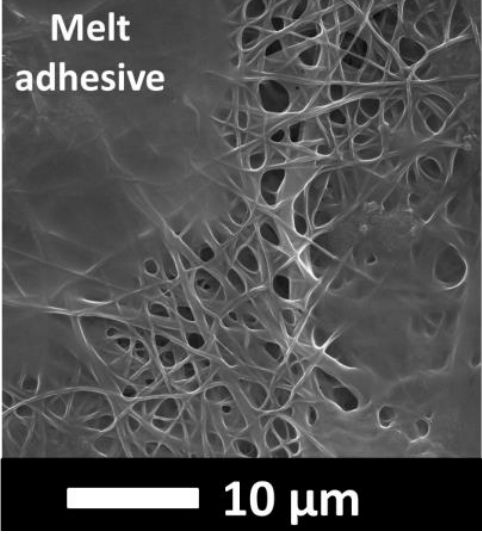
Figure 10. An illustration of adhesive melting over the surface of a nanofiber web, forming a non-porous film.